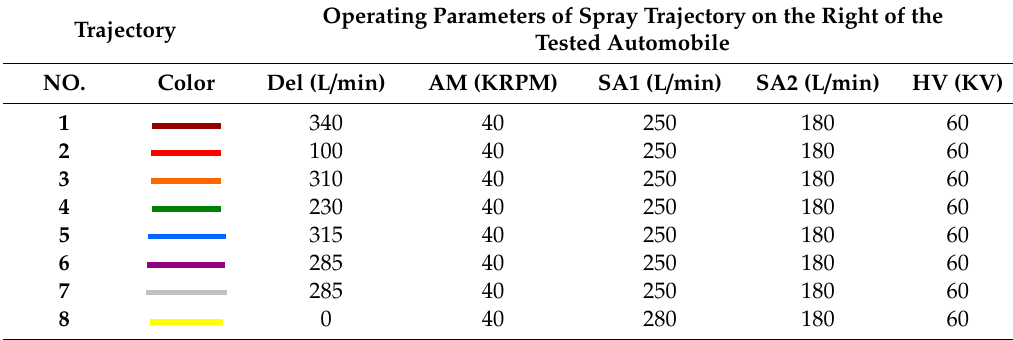
Table 2. Operating parameters of the spray painting trajectory on the left.